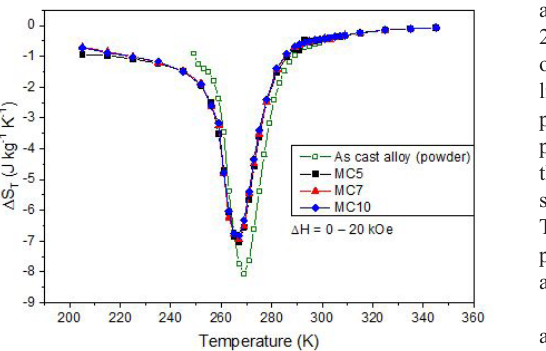
Ge Si powder, MC5, MC7 and MC10. The insets on the graphs are the derivatives of the curves. 5.09 2.03 1.88